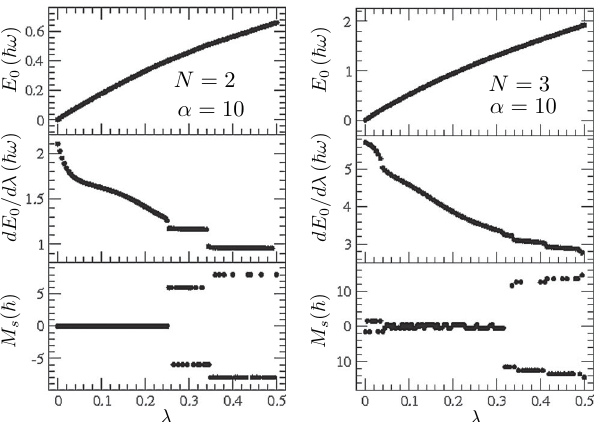
FIG. 6. Exact-diagonalization results for the ground-state en- ergy E 0 and the magnetization M s vs the interaction parameter λ , for α ¼ 10 and N ¼ 2 (left) and N ¼ 3 (right). The top row shows E 0 ð λ Þ , where singular structures are visible in the derivative dE 0 =d λ , as depicted in the center panels. The bottom panels show the magnetization M s , where M s ≠ 0 for λ > λ c . (For N ¼ 3 , a finite but very small value for M s numerically appears already for λ c < 0 . 31 .) FIG. 7. Same as Fig. 6 but for α ¼ 15